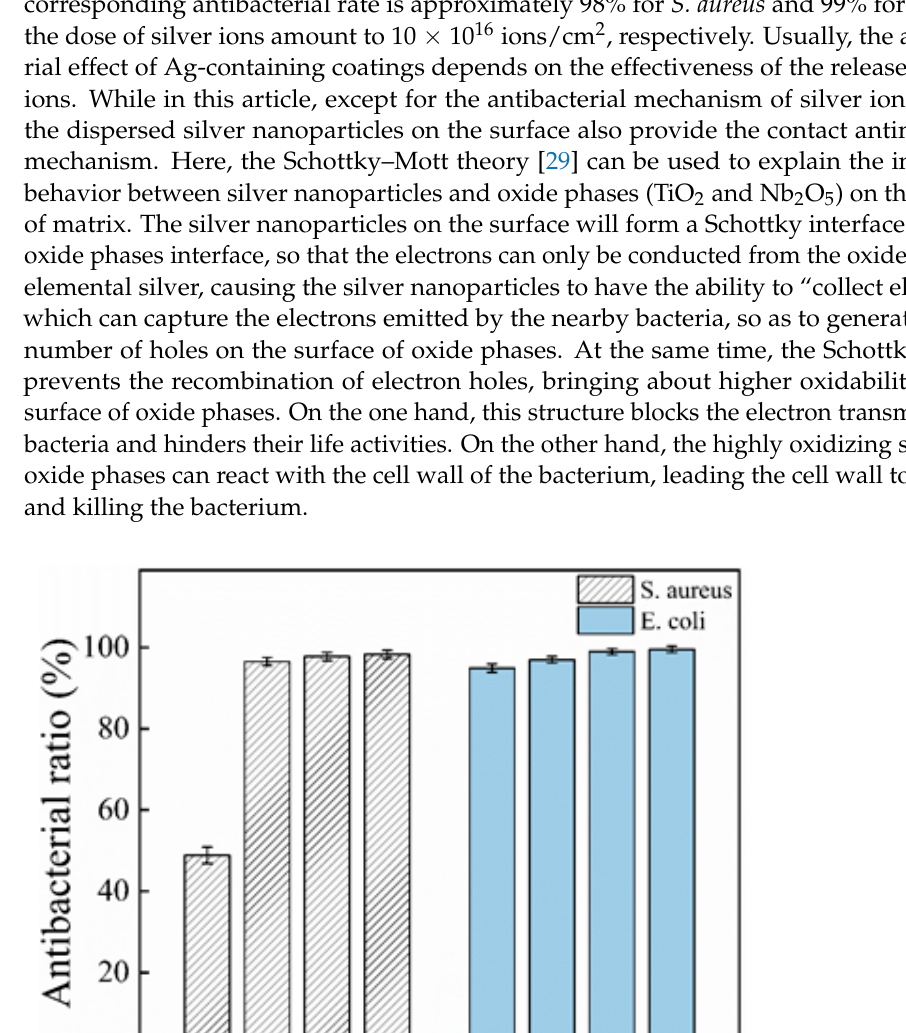
Figure 11. Typical photos of the re-cultivated E. coli colonies on agar for different samples: ( a ) Substrate; ( b ) Ag-1×10 16 Figure 11. ions/cm 2 ; ( c ) Ag-5×10 16 ions/cm 2 ; ( d ) Ag-10×10 16 ions/cm 2 ; ( e ) Ag-15×10 16 ions/cm 2 .